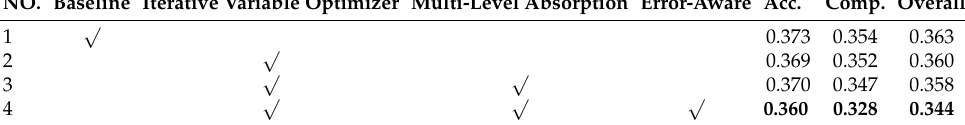
Table 4. Ablation Study on DTU dataset [46] ( ↓ ). Our baseline consists of the depth initialization in Figure 3, followed by a single-scale GRU iterative optimization operator. Bold font represents the